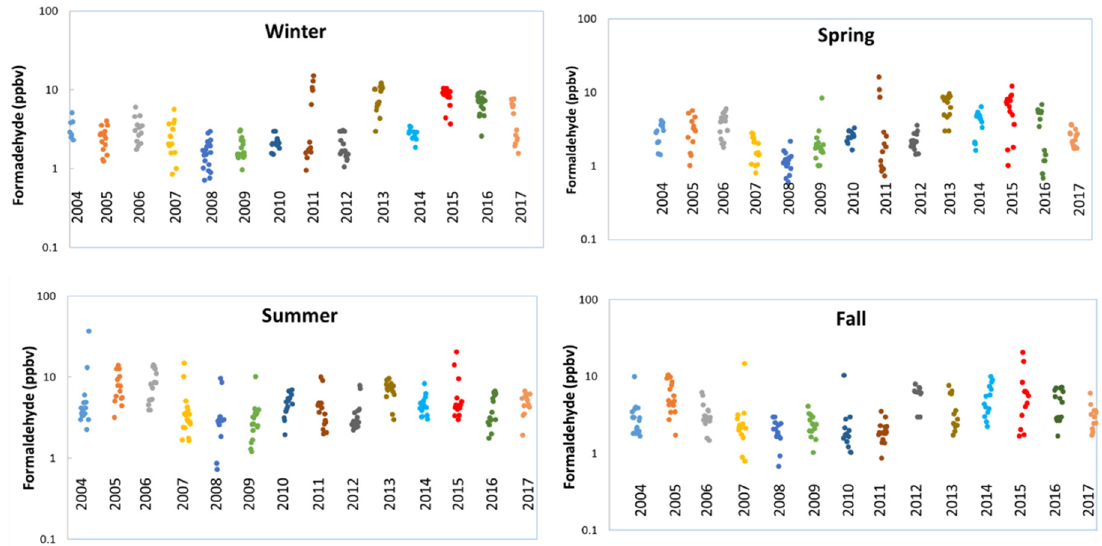
Figure 2. Formaldehyde seasonal variations. Winter: December, January and February; Spring: March, April and May; Summer: June, July and August and Fall: September October and November.